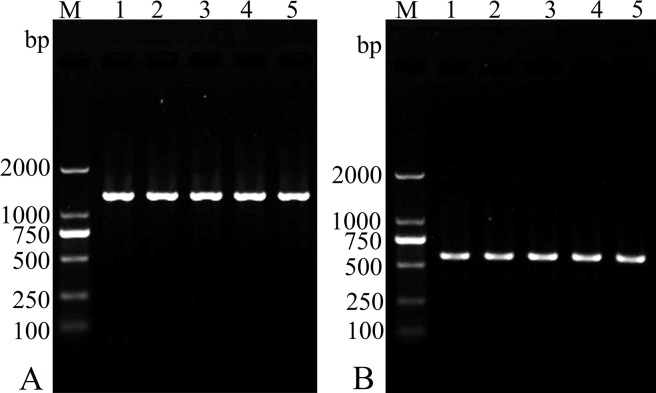
RT-PCR assay of TsSP transcription at different T. spiralis phases.RT-PCR assay of the mRNA transcription of TsSP (A) and GAPDH (B) at various T. spiralis stages. M: DNA marker; Lane 1: ML; Lane 2: IIL; Lane 3: AW at 3 dpi; Lane 4: AW at 6 dpi; Lane 4: NBL.